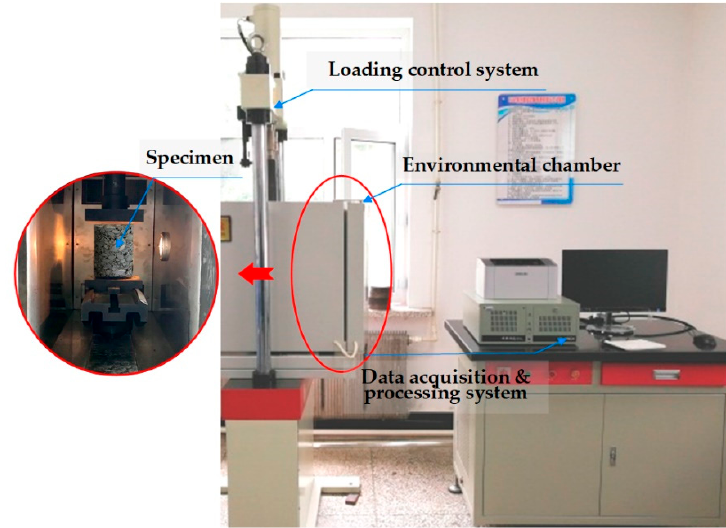
Figure 3. High-temperature uniaxial compression test used in this paper.